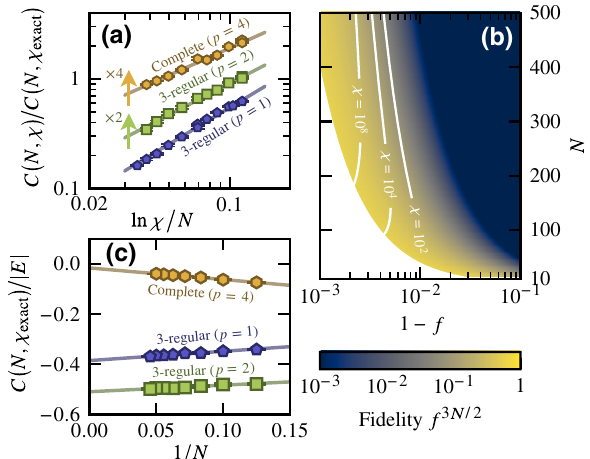
FIG. 3. (a) The scaling function Y = F ( X → 0 ) for unit- weight 3-regular graphs with p = 1 and p = 2 (data shifted vertically by a factor of 2 for readability) and complete graphs with uniform random weights w ij ∈ [0, 1] and p = 4 (data shifted vertically by a factor of 4 for readability). The N = 8 data are discarded due to their deviation to the scaling. The bold lines are a fit following Eq. (4) with parameters A = 6.9 ( 6 ) , 4.0 ( 3 ) , and 3.1 ( 2 ) , and α = 1.10 ( 3 ) , 0.95 ( 3 ) , and 0.82 ( 3 ) , respectively. (b) The overall fidelity f K , where f is the average fidelity of individual operations and K = 3 N / 2 is the number of opera- tions. Using the parameters A ≈ 6.9 and α ≈ 1.10 extracted from (a) for the case of unit-weight 3-regular graphs with p = 1, we plot iso- χ lines according to Eq. (7). (c) Extrapolation of the exact cost for arbitrary N for the three cases considered. The straight lines are fits according to Eq. (5), with parameters c 0 = = 0.37 ( 3 ) , c = − 0.509 ( 3 ) and c = 0.26 ( 4 ) , − 0.385 ( 2 ) and c 1 0 1 and c 0 = − 0.0157 ( 4 ) and c 1 = − 0.462 ( 6 ) , for unit-weight 3- regular graphs with p = 1 and p = 2 and complete graphs with uniform random weights w ij ∈ [0, 1] and p = 4,